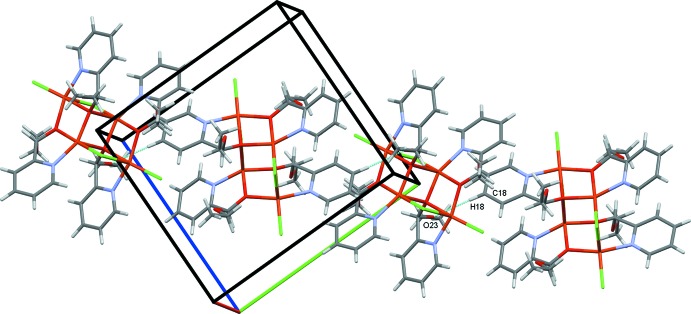
Chains of mol­ecules of II along the bc diagonal.